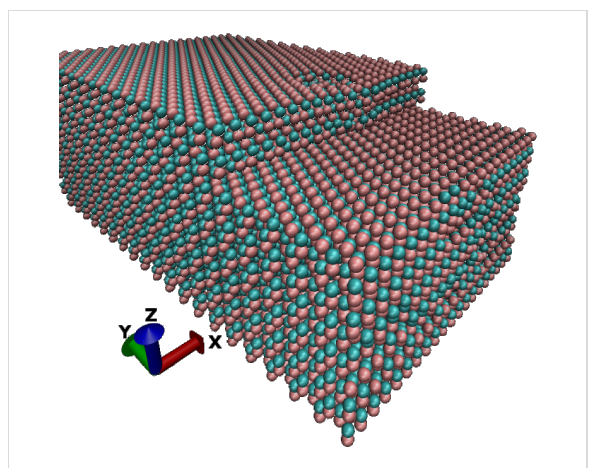
Figure 1: MD configuration of a GaN step with a step height of h = 2 c during indentation of surface atoms within a circular area of A 2 = 1.232 nm 2 . The red spheres denote the gallium and blue spheres the nitrogen atoms.